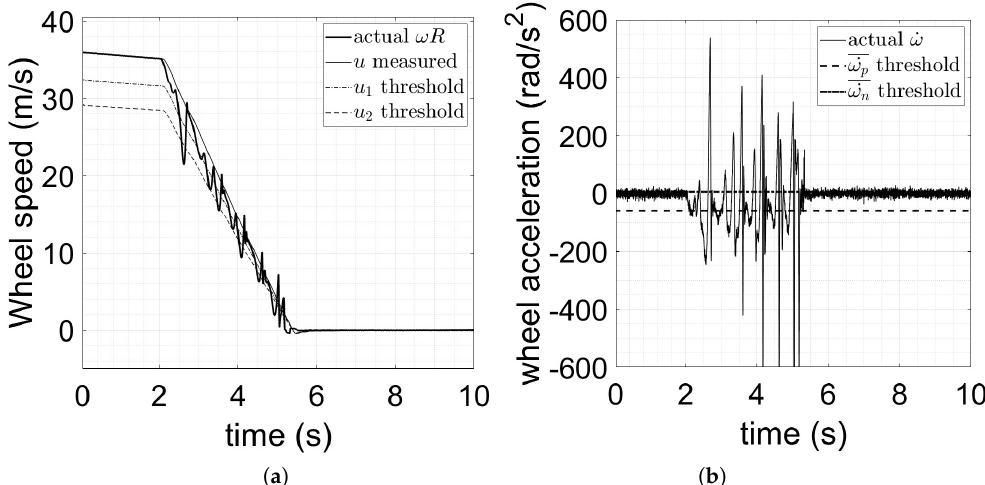
Figure 3. Standard ABS threshold work; Figure ( a ) shows the control on the wheel speed, and the Figure ( b ) shows the control on the wheel